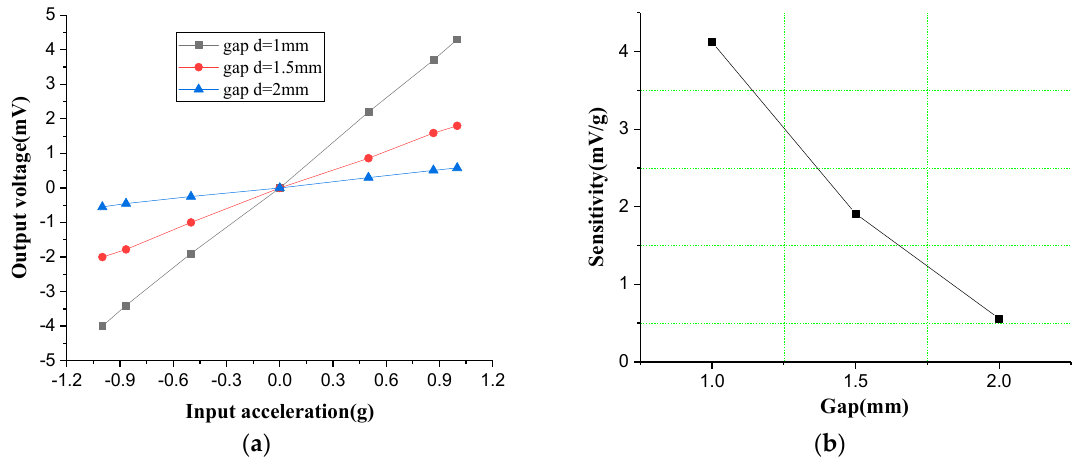
Figure 10. Acceleration input and output response characteristics under different gaps in the tunneling magnetoresistive accelerometer. ( a ) Input acceleration versus output voltage under different gaps; ( b ) The sensitivity versus gap.